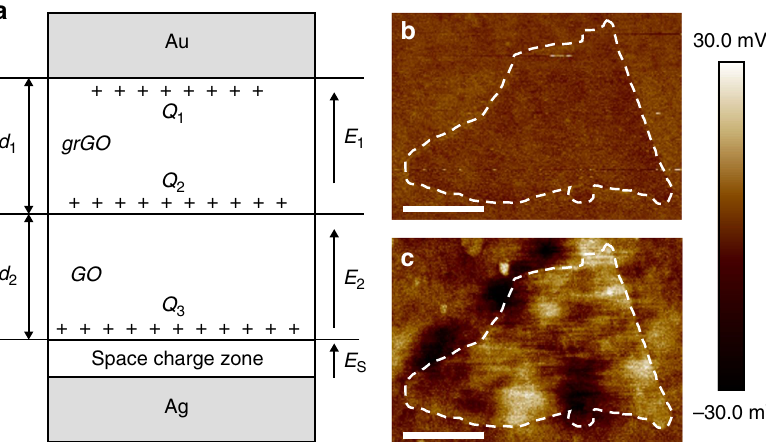
Fig. 5 Mechanism for the hygroelectric generator. a Theoretical model for the proposed working principle of HEG (Ag/GO-grGO/Au) in which the Au electrode contacts with graphene oxide (GO) side of heterogeneous graphene oxide (h-GO) while Ag electrode contacts with gradient reduced graphene oxide (grGO) side of h-GO. The h-GO is composed of grGO and GO with a thickness of d 1 and d 2 , respectively. Q 1 , Q 2 , and Q 3 represents the induced positively charge quantity at Au/grGO, GO/grGO, and GO/Ag interfaces, respectively. The built-in electric fi eld at grGO, GO and space charge zone is represented by E 1 , E 2 , and E s , respectively. b , c Electrostatic force microscopy (EFM) images of graphene oxide ( b ) and in situ laser-induced reduced graphene oxide ( c ) sheets at low relative humidity. The color bar represents the surface potential variation. Scale bars: 1 μ m